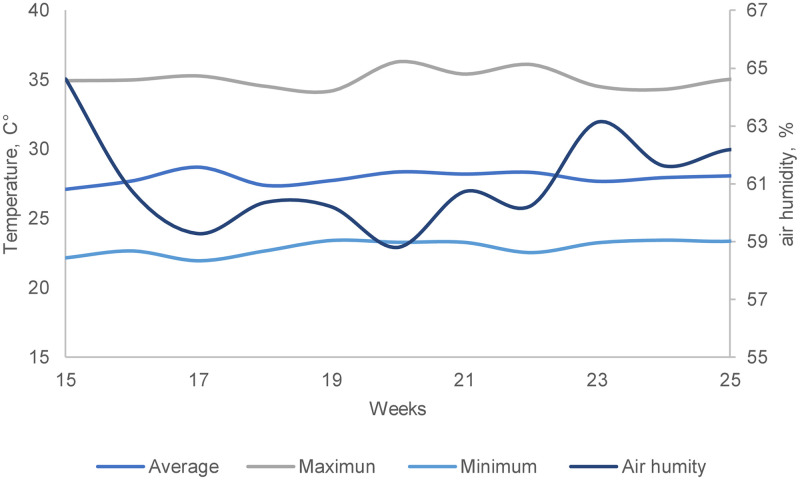
Mean variation of temperature (T, °C) and relative air humidity (%) during the ten weeks of the experimental period.